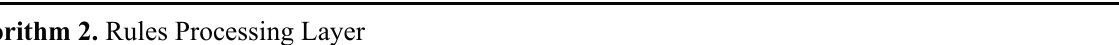
Algorithm 2. Rules Processing Layer